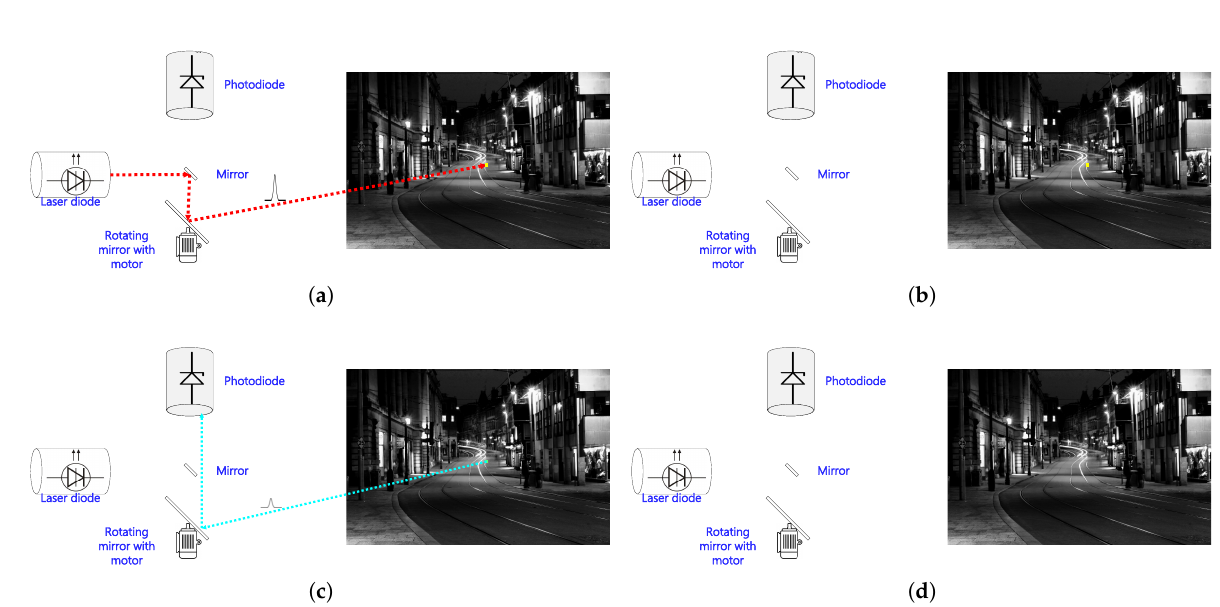
Figure 3. Operating strategy of the single-laser SICK LMS511 LIDAR. ( a ) The LIDAR fires a pulse of the laser at the target; ( b ) the LIDAR waits for the reflection of the laser; ( c ) after reception, the LIDAR calculates the target distance with the ToF; and ( d ) the LIDAR rotates the mirror to the next angle and restarts from ( a